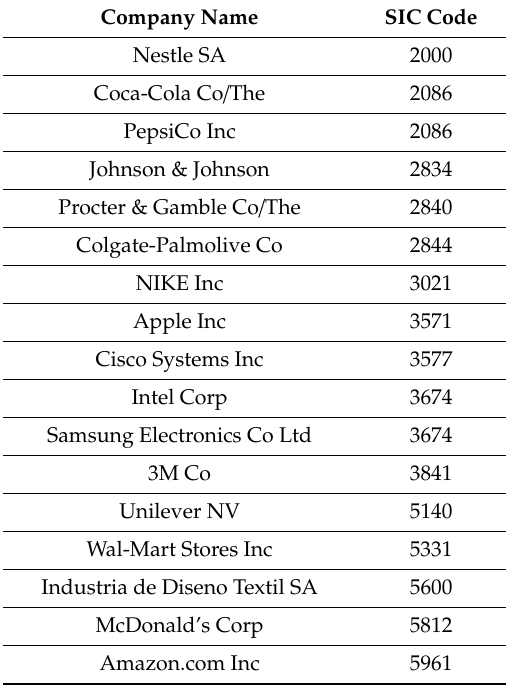
Table A1. SCL firms and four-digit SIC codes (after adjustments).